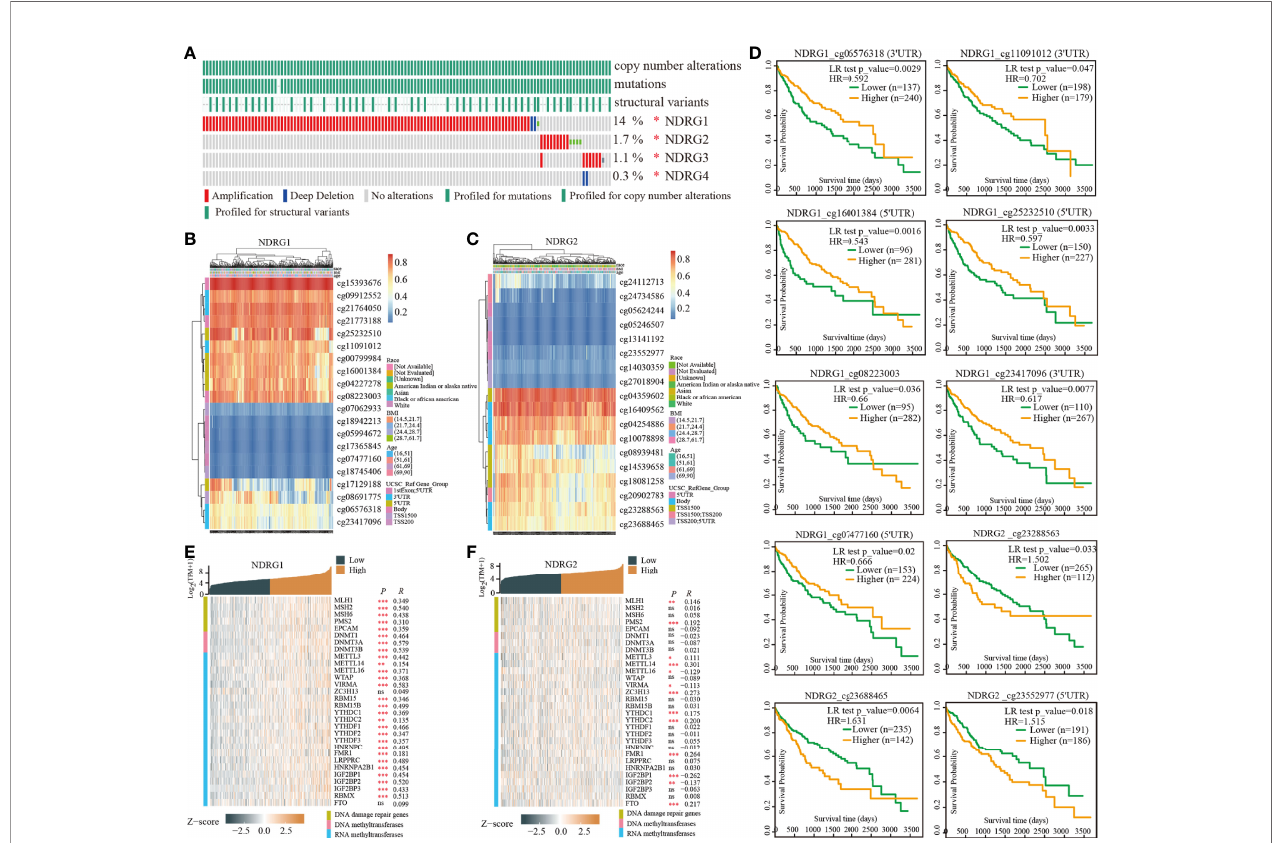
FIGURE 2 | The analysis of DNA mutation and methylation of NDRG1 or NDRG2. (A) The overview of DNA mutation of the NDRGs family genes, mapped by cBioPortal (http://www.cbioportal.org/). (B, C) The DNA methylation clustered expression of NDRG1 and NDRG2 by using MethSurv © 2017 (https://biit.cs.ut.ee/ methsurv/). Red to blue represents a high to low expression. (D) The signi fi cantly prognostic values of the promoter CpGs in NDRG1 and NDRG2 obtained from MethSurv © 2017. (E, F) The heatmaps of NDRG1 and NDRG2 expression in relation to DNA repair genes and methyltransferases. * P < 0.05, ** P < 0.01, *** P < 0.001. NS, no signi fi